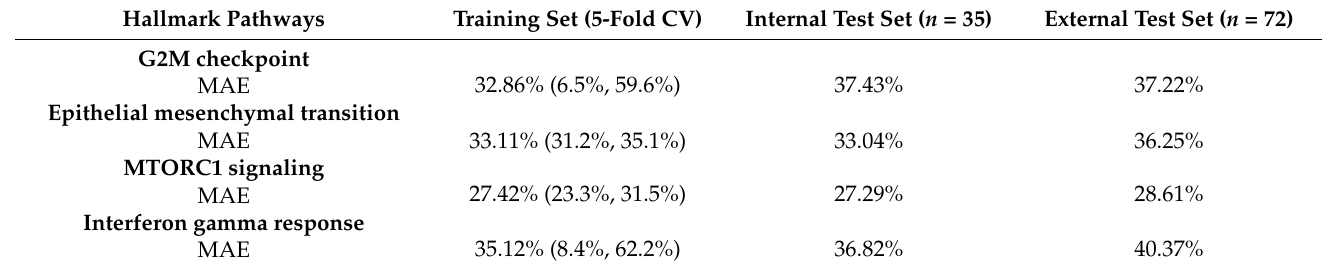
Table 4. The prediction performance of the GSVA enrichment scores of hallmark pathways based on radiomic features. The random forest prediction models of enrichment scores for four representative hallmark pathways were built in the internal training set and validated in the independent internal and external test sets. Five-fold cross-validation (CV) was performed to avoid overfitting, and MAE was used to evaluate model performance. The 95% CI was used to evaluate the performance stability during the 5-fold CV.